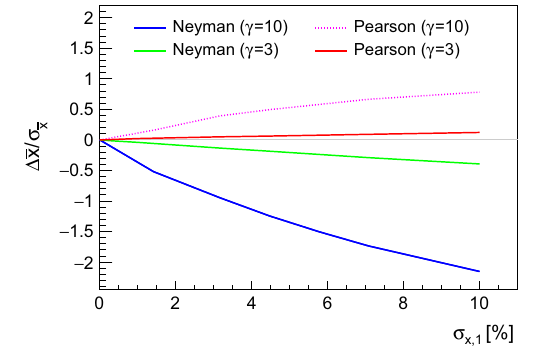
Fig. 2 Relative total uncertainty of the pseudo-measurement a for dif- ferent values of the threshold t entry, X α μ , in at least one of the bins. Therefore, the Poisson likelihood is approximated with a Gaussian form, which is valid for low statistical uncertainties such as in this test.